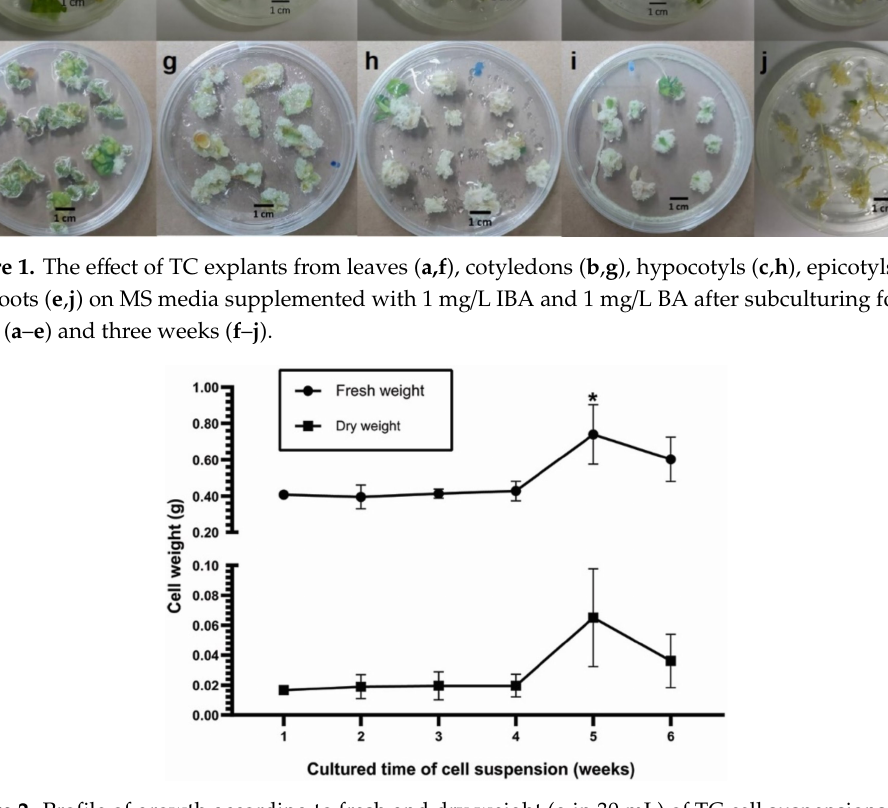
Figure 2. Profile of growth according to fresh and dry weight (g in 30 mL) of TC cell suspensions at the indicated cultured times (week). Data are presented as the mean ± standard deviation from three cell lines. The asterisk indicates significance (* p -value < 0.05 by t -test from Microsoft Excel